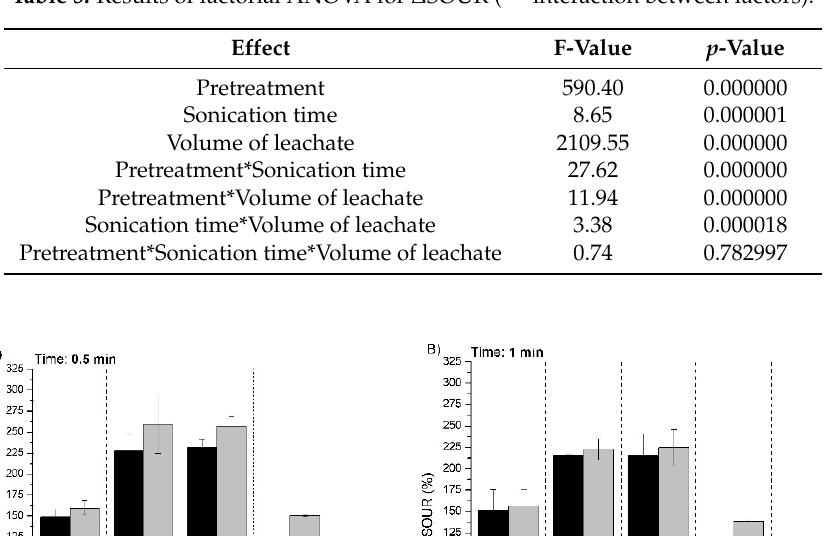
Table 5. Results of factorial ANOVA for ∆ SOUR (*—interaction between factors).